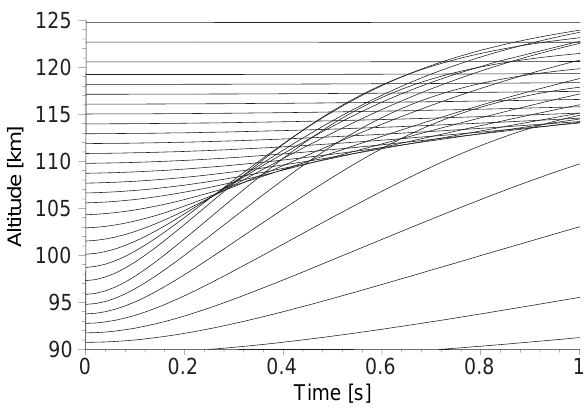
Fig. 4. Phase fronts calculated from the crossing characteristics of Fig. 3 at intervals of 0.1 seconds. This figure shows that some char- acteristics are associated with multiple phase values: for example S( 117 km , 0 . 8 s ) has values of 395 rad, 415 rad and 425 rad all at the same time and